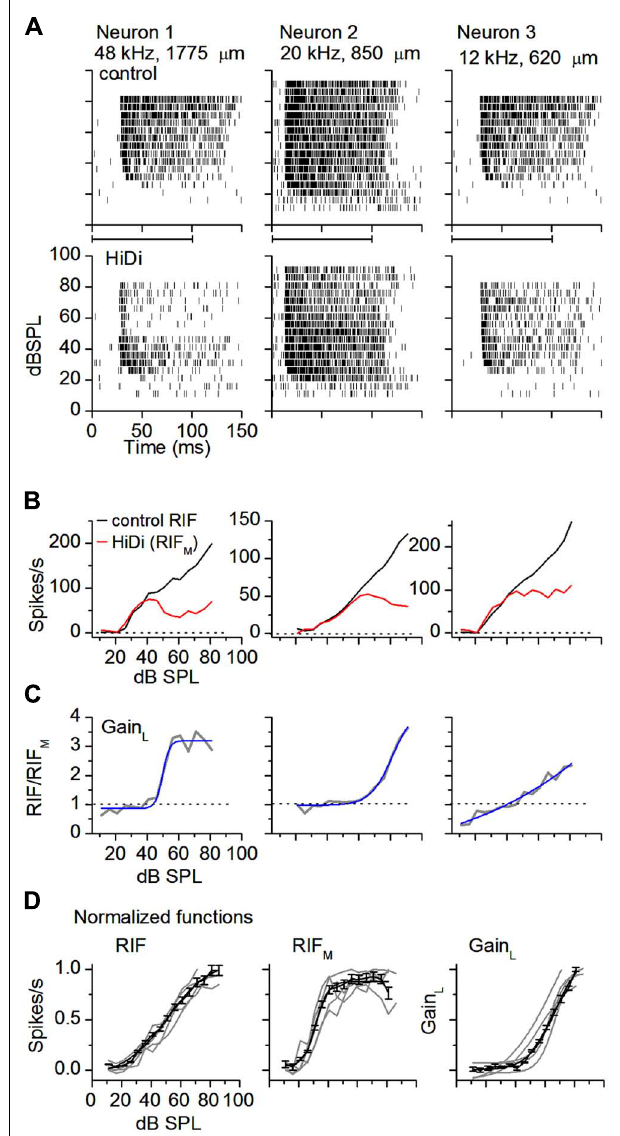
FIGURE 2 | External inputs and local circuits combine to widen dynamic range. (A) HiDi decreases firing rate at mid- to high sound intensities. Spike rasters in three monotonic neurons in control (top panels) and in 2.5 HiDi (bottom panels). CFs and recording depths are indicated. Horizontal bar at abscissa: tone duration. (B) Rate-intensity functions show a wide dynamic range, intensity-variant, response (RIF) for each of the cells in (A) . HiDi decreases the dynamic range, and the RIF in HiDi, due to the monosynaptic input (RIF M ), is saturating or slightly non-monotonic at higher intensities. Firing rates are averaged over 12 presentations of the tone at each sound pressure level. (C) The gain of the local circuit, Gain L , is the ratio of firing rates in control and HiDi. Gain L = RIF/RIF M , increases with sound intensity. Gain L is plotted as a function of sound intensity for each of the neurons in (B) . A gain < 1 in the right panel is due to a slightly higher firing rate in HiDi at low intensities ( ∼ six spikes/s at 11 and 16 dB SPL). Sigmoidal fits. r 2 from left to right: 0.95956, 0.98407, and 0.94814. (D) Normalized RIFs in control and HiDi and normalized Gain L for five neurons with control dynamic ranges ≥ 60 dB (gray lines). Black lines: population average of normalized RIFs and Gain L . 33 cells. Mean and s.e.m. Sigmoidal fits: RIF, r 2 = 0.9942; RIF M , r 2 = 0.9846; Gain L , r 2 =